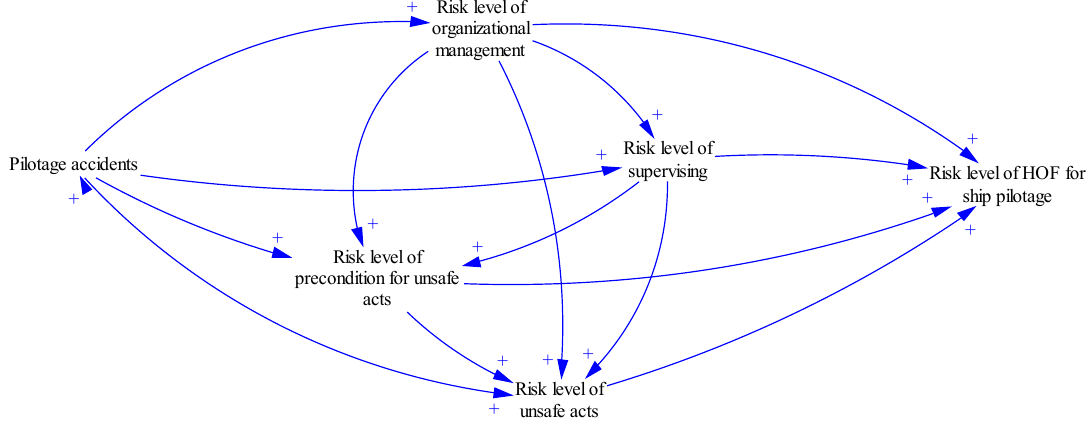
Figure 3. Causal relationship flow graph in the complex human factors analysis and classification system (HFACS) system.